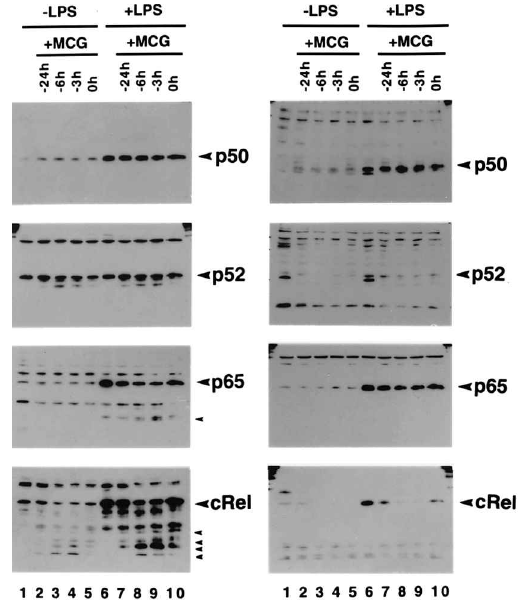
FIG. 7. Western analyses of nuclear proteins using antibodies against N (left) or C (right) terminal peptides of p50, p52, p65, or c-Rel. J774 cells were cultured for varying periods of time, as in Fig. 5, without MCG (lane 1 and 6) or with MCG (lanes 2 to 5 and 7 to 10) at a macrophage to mast cell ratio of 5 to 1. After the pretreatment, cells were cultured for an addi- tional 30min without (lanes 1 to 5) or with (lanes 6 to 10) LPS. Nuclear proteins were then prepared and Western analyses were carried out as described in the Experimental